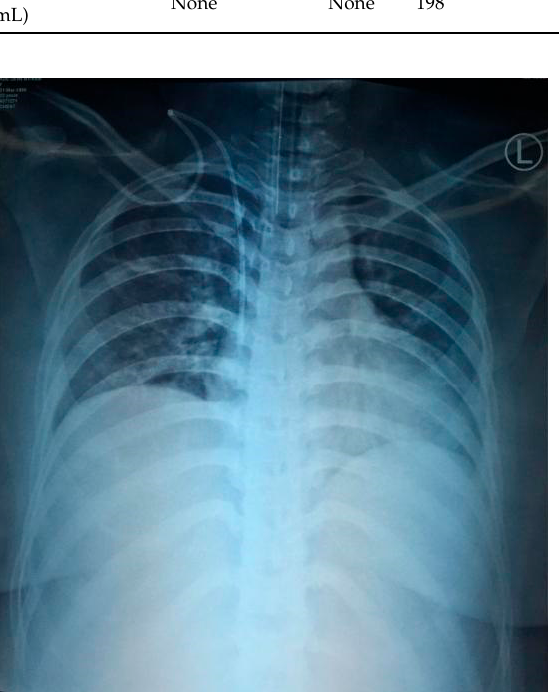
Figure 2. Thorax X-ray showed infiltrate on right suprahilar, perihilar, and paracardial with Figure 2. ThoraxX-rayshowedinfiltrateonrightsuprahilar, perihilar, andparacardialwithcranialization cranialization of broncho-vascular with differential diagnosis of pneumonia and lung oedema, of broncho-vascular with differential diagnosis of pneumonia and lung oedema, suspected bilateral suspected bilateral pleural effusion. pleural Table 1. Daily laboratory trend and therapy.